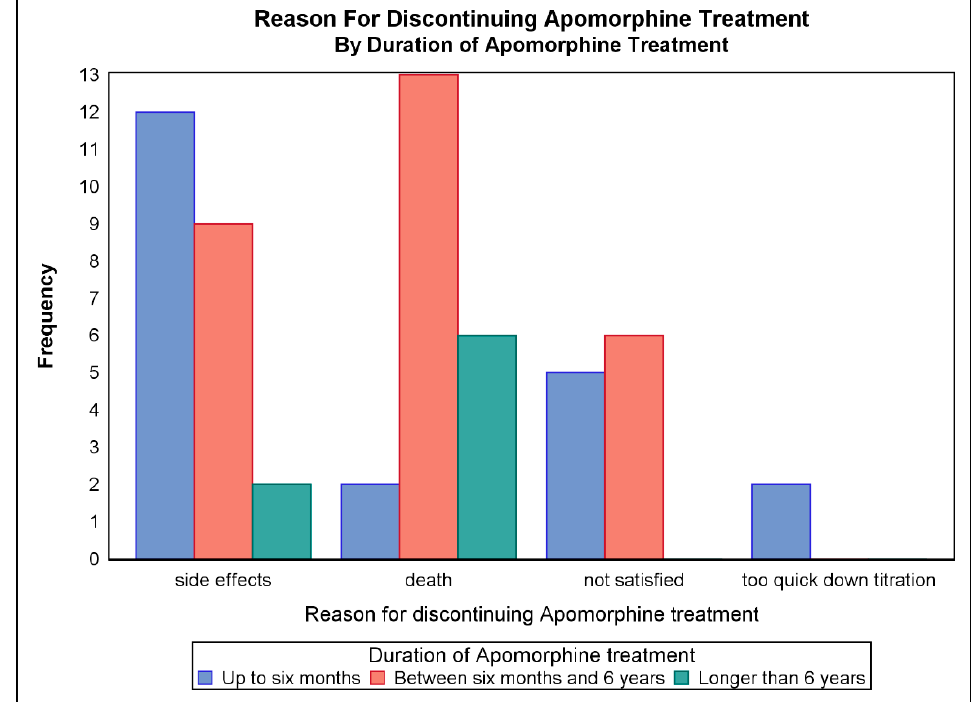
Figure 2. Reasons for discontinuing SCAI therapy according to duration of treatment.